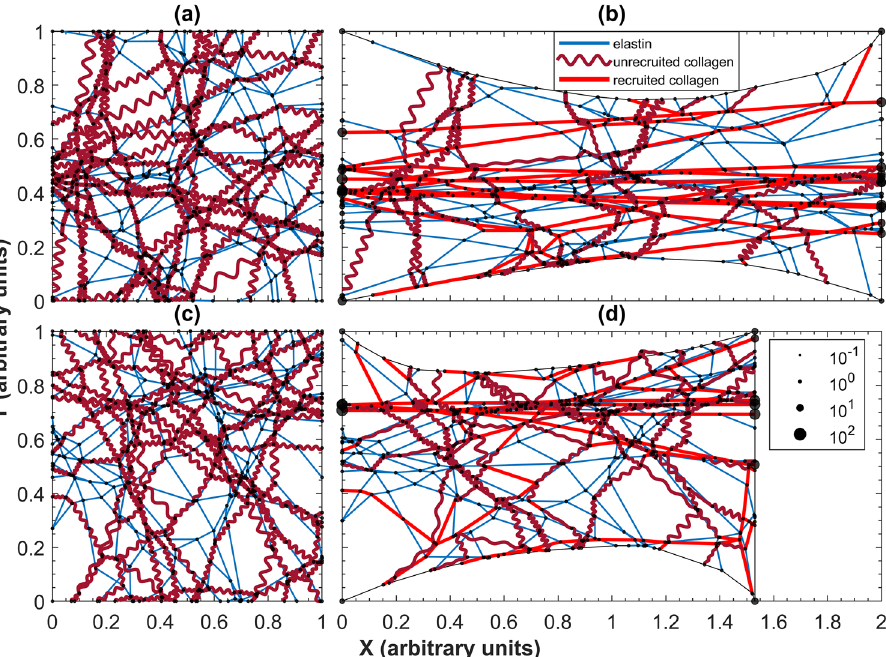
Figure 1. Sample alveolar networks before and after stretching. Elastin fibers are blue and collagen fibers are red. The dark red represents unrecruited collagen, the arc length of each fiber is equivalent to its resting length. Bright red is recruited collagen. Nodes occur where two fibers are cross-linked, and their size represents the net force on the node with logarithmic scaling. The examples shown correspond to: ( a ) initial healthy condition, ( b ) stretched healthy condition, ( c ) initial severe fibrotic condition, and ( d ) stretched fibrotic condition. The maximum stretches in each case reflect those in Fig. 2a. Videos of this stretching process for the healthy and fibrotic conditions can be found in Supplemental Videos 1 and 2,